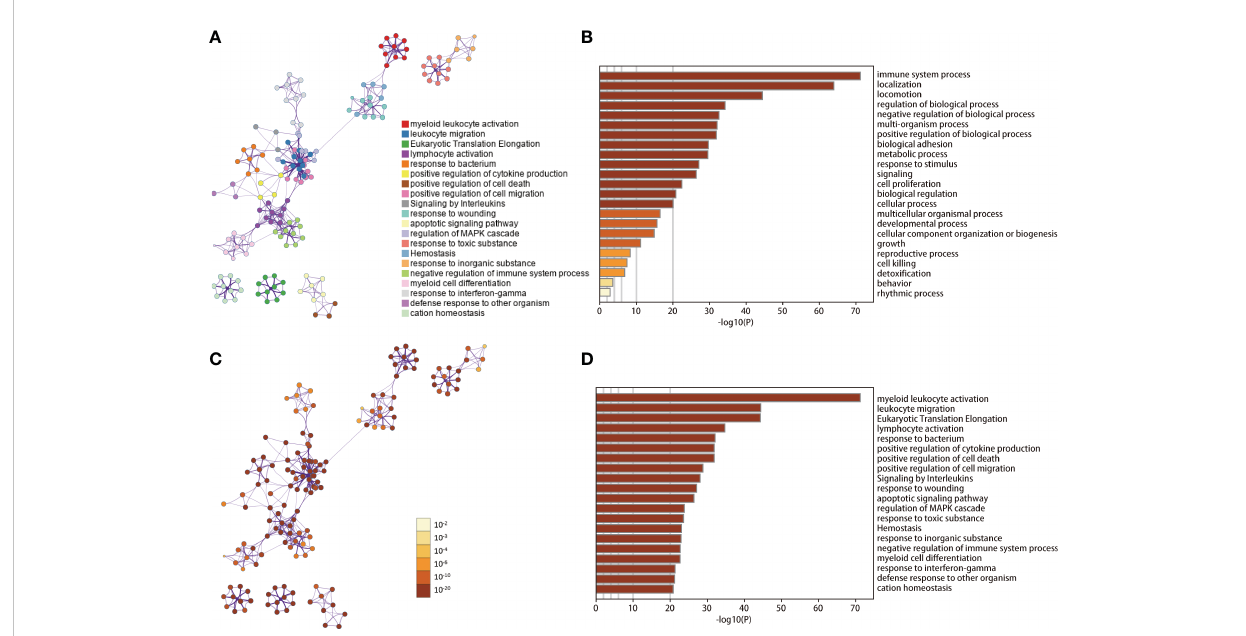
FIGURE 3 GO/KEGG enrichment analysis of DRGs. (A, C) Network of enriched terms. (B, D) Bar graph of GO/KEGG enrichment analysis across DRGs. Results in B-D are colored by p-values. DRGs, Differentiation Related Genes; GO, Gene Ontology; KEGG, Kyoto Encyclopedia of Genes and